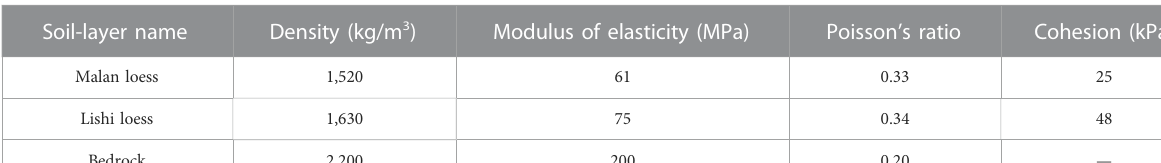
TABLE 5 Slope model mechanical parameters of soil layers.